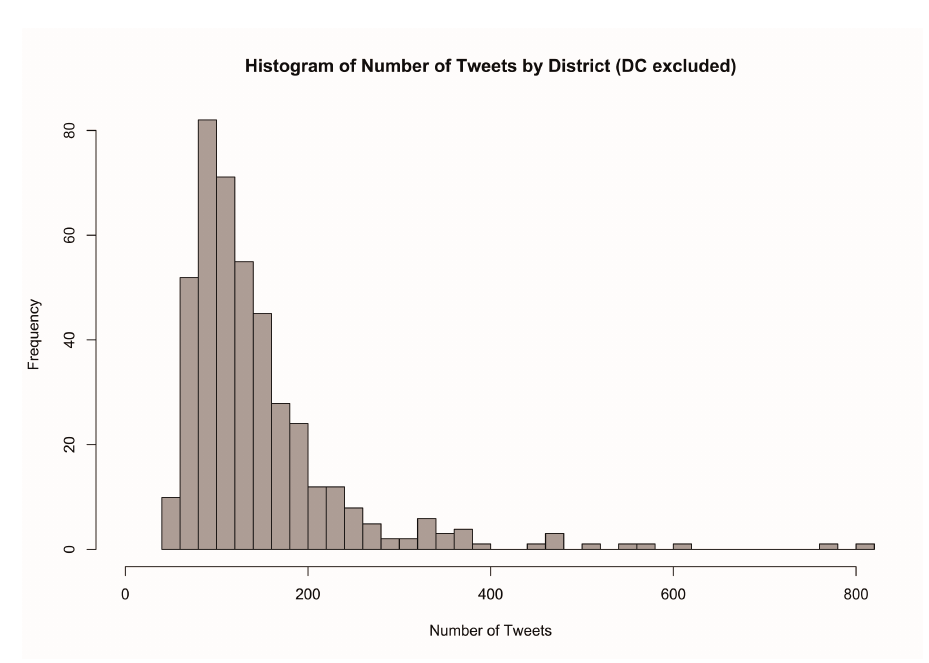
Figure 2. Distribution of tweets by state.